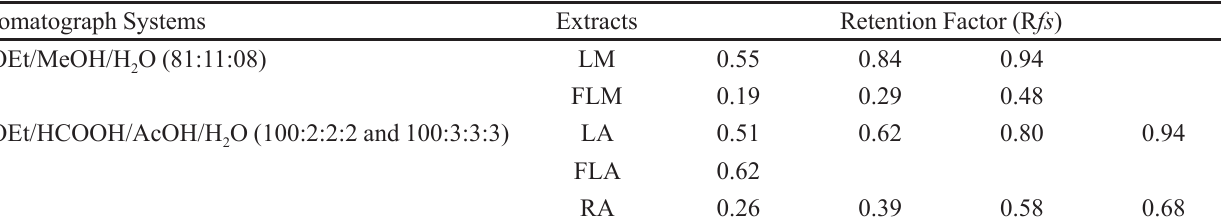
TABLE IV - Minimum Inhibitory Concentration (MIC) of extracts from Caesalpinia pyramidalis against Staphylococcus aureus strains MIC of extracts from Caesalpinia pyramidalis (mg mL -1 ) STRAINS